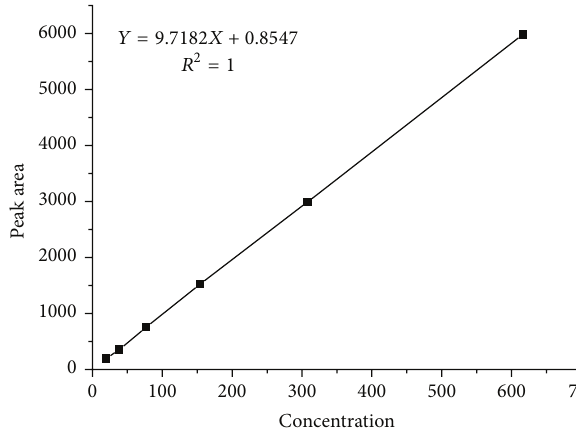
Figure 5: Capsaicin calibration